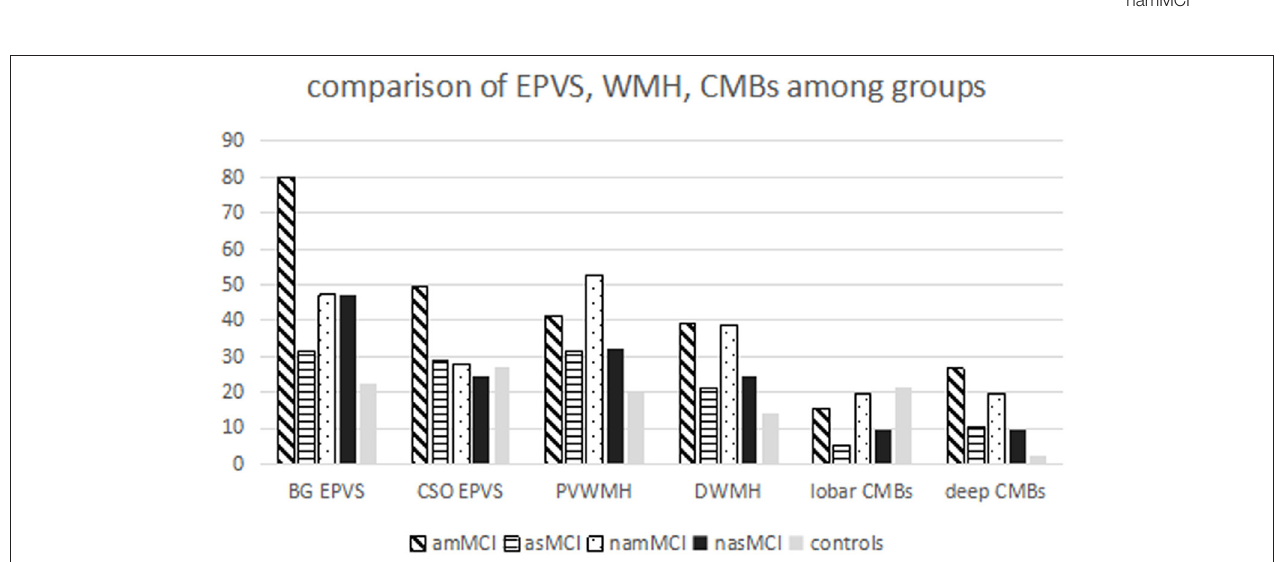
FIGURE 1 | Comparison of EPVS, WMH, and CMBs among all groups.